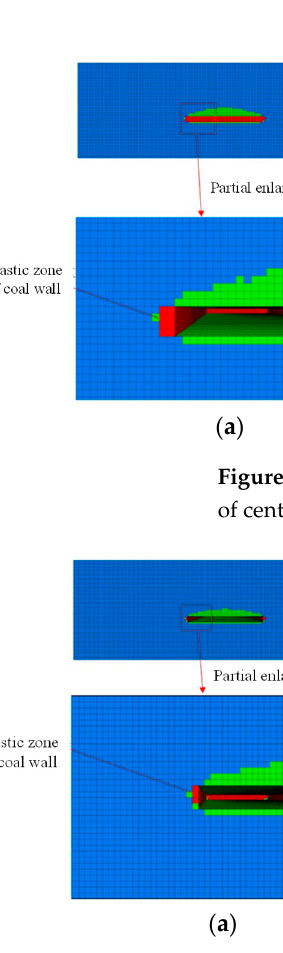
Figure 12. Plastic zone of coal wall after grouting. ( a ) Plastic zone of end coal wall; ( b ) Plastic zone of central coal wall.